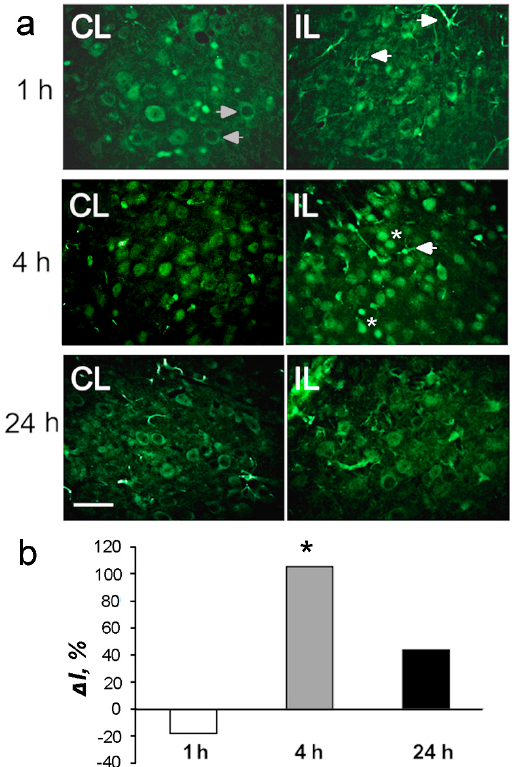
Figure 4. The cellular distribution and expression of histone deacetylase HDAC1 in the penumbra at 1, 4 or 24 h after photothrombotic stroke in the rat cerebral cortex. ( a ) The typical immunofluorescence images of HDAC1 localization in the ischemic penumbra (IL, right column) and in the control contralateral cortex (CL, left column). Arrows in the left column indicate cells with cytoplasmic HDAC1, arrows in the right columns show the expression of HDAC1 in cellular processes. Asterisks—neuronal nuclei. Scale bar, 20 µ m. ( b ) Percent changes in the fluorescence intensity of HDAC1-positive cells in the ischemic penumbra 1, 4 or 24 h after photothrombotic stroke (PTS) in the rat cerebral cortex relatively to that in the contralateral cortex. ∆ I % is the mean corrected total cell fluorescence (CTCF) averaged over penumbra minus mean control CTCF / mean control CTCF × 100% (experiment versus control). n = 5. * p <